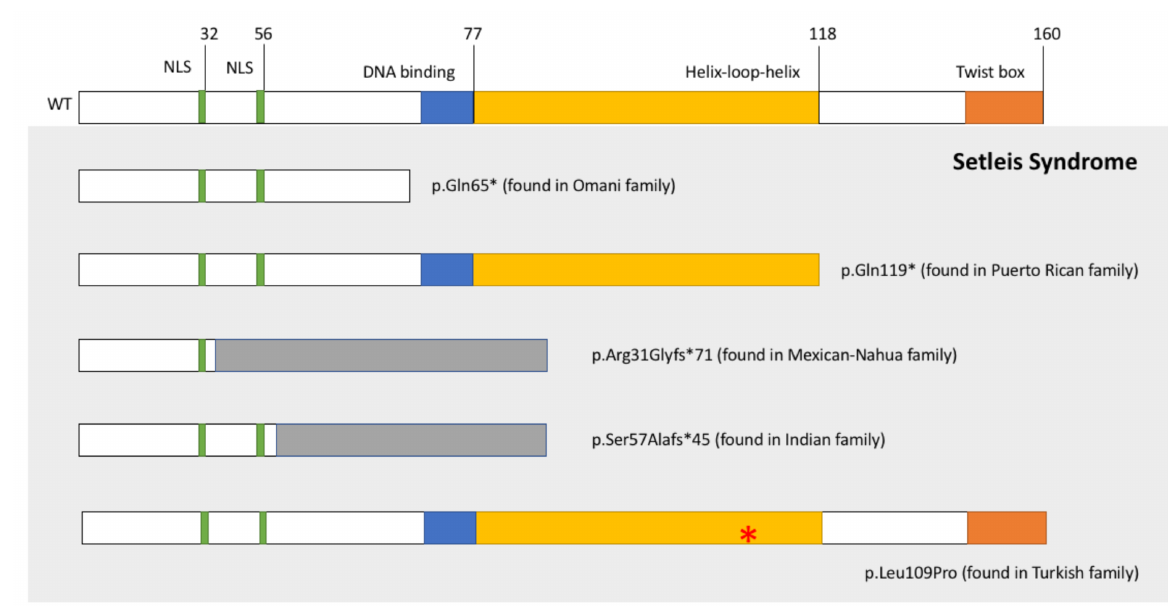
Figure 1. The schematic domain structure of TWIST2 protein and the location of TWIST2 mutations identified in SS patients. NLS, nuclear localization signal. Since the original report by Tukel et al., five different homozygous mutations in the TWIST2 gene have been identified p.Gln65*-Omani, p.Gln119*-Puerto Rican, p.Arg31Glyfs*71-Mexican-Nahua, p.Ser57Alafs*45- Indian and p.Leu109Pro-Turkish families. All five TWIST2 mutations are suggested to alter dimer formation. Grey bars represent regions in the proteins predicted to have a different amino acid sequence than the wild type